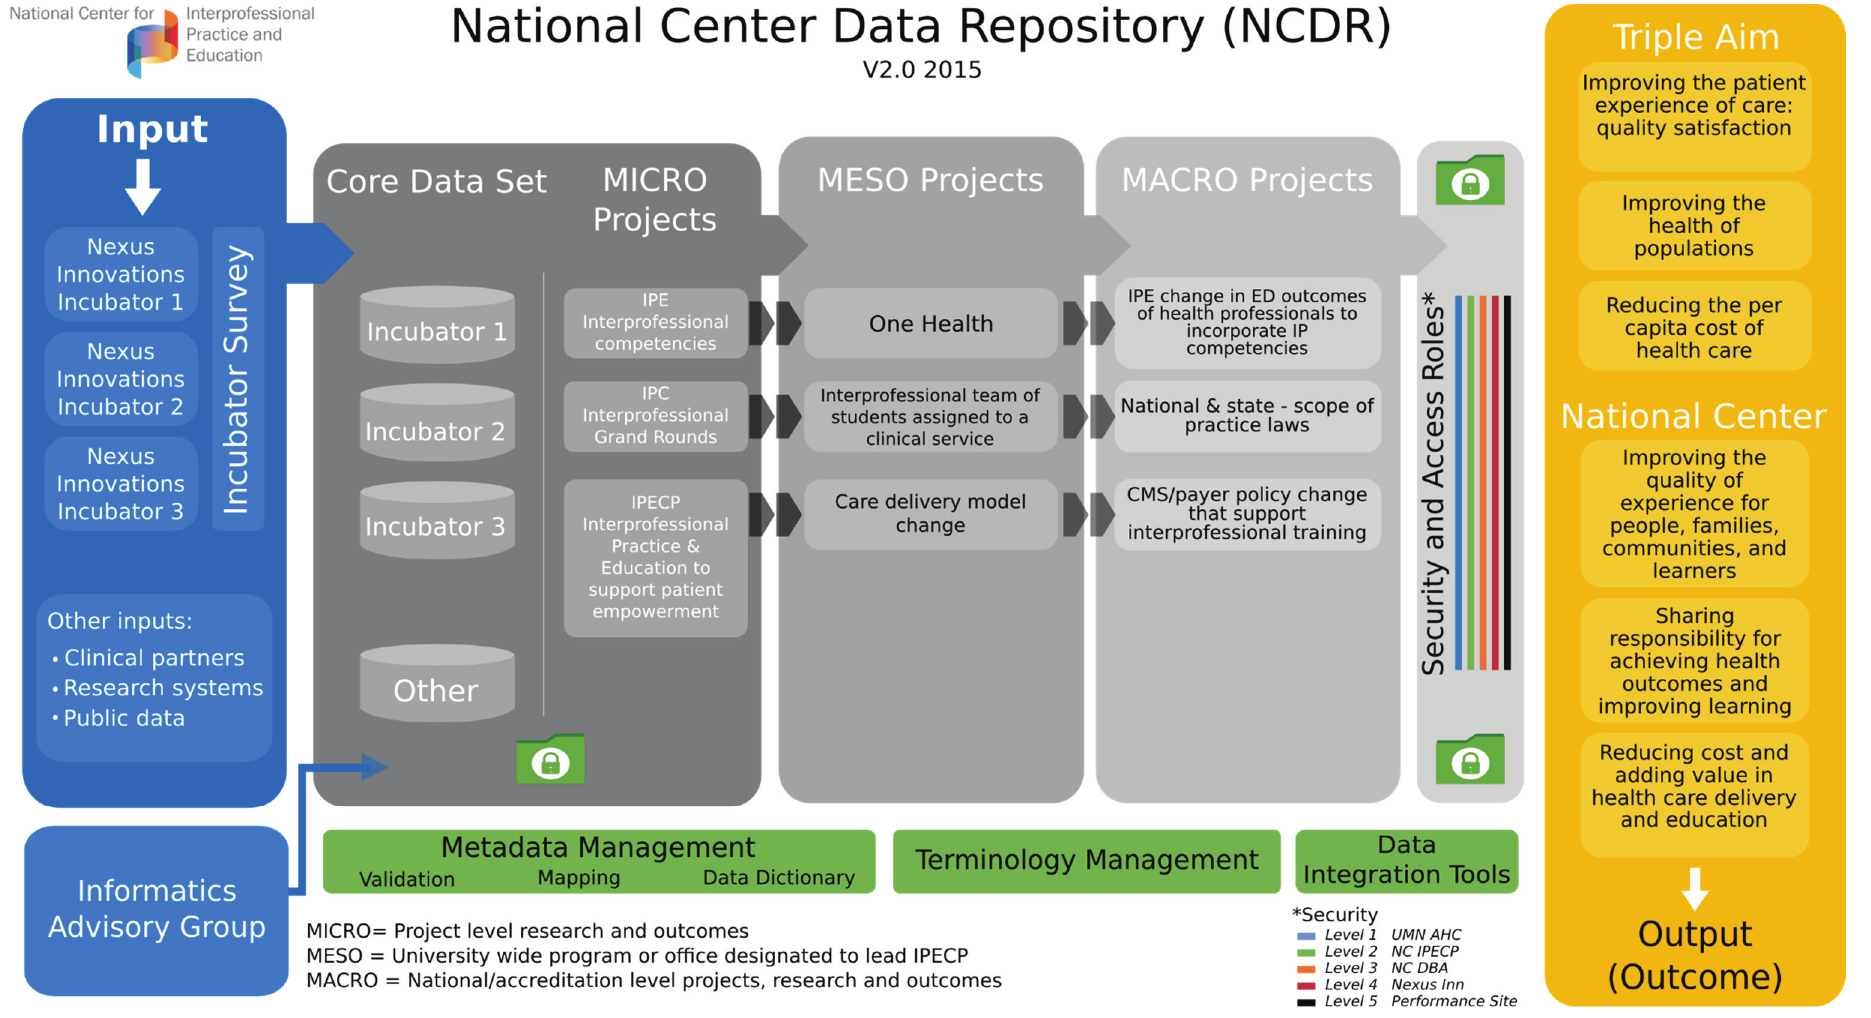
Figure 4. The incubator network and the national center data